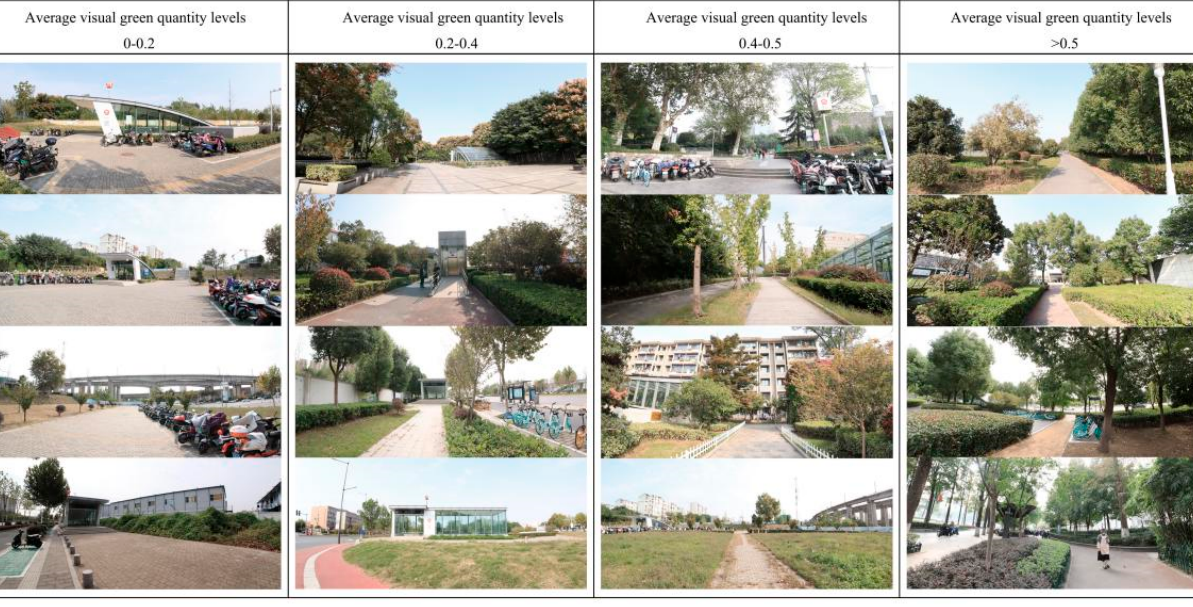
Figure 7. Examples of acquisition results of different average visual green quantity levels.